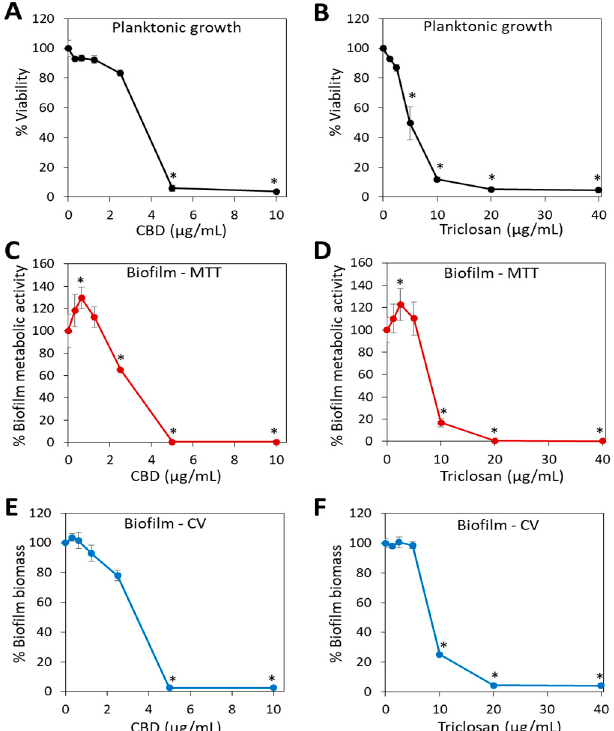
Figure 1. The anti-bacterial and anti-biofilm activity of CBD and triclosan against S. mutans . ( A , B ). S. mutans was exposed to various concentrations of CBD ( A ) or triclosan ( B ) in BHI for 24 h, and the planktonic growth was determined by measuring the OD at 600 nm. ( C – E ). S. mutans was exposed to various concentrations of CBD ( C , E ) or triclosan ( D , F ) in BHIS for 24 h, and the metabolic activity of the formed biofilms was measured by the MTT assay ( C , D ), and the biofilm biomass was determined by staining with crystal violet (CV) ( E , F ). * p < 0.05 when compared to control bacteria. N = 3.